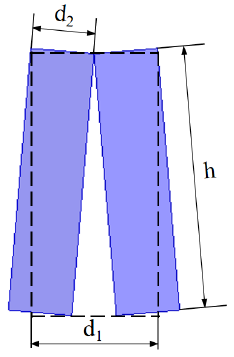
Figure 5. Structure diagram of a single permanent magnet for IPMSMB.